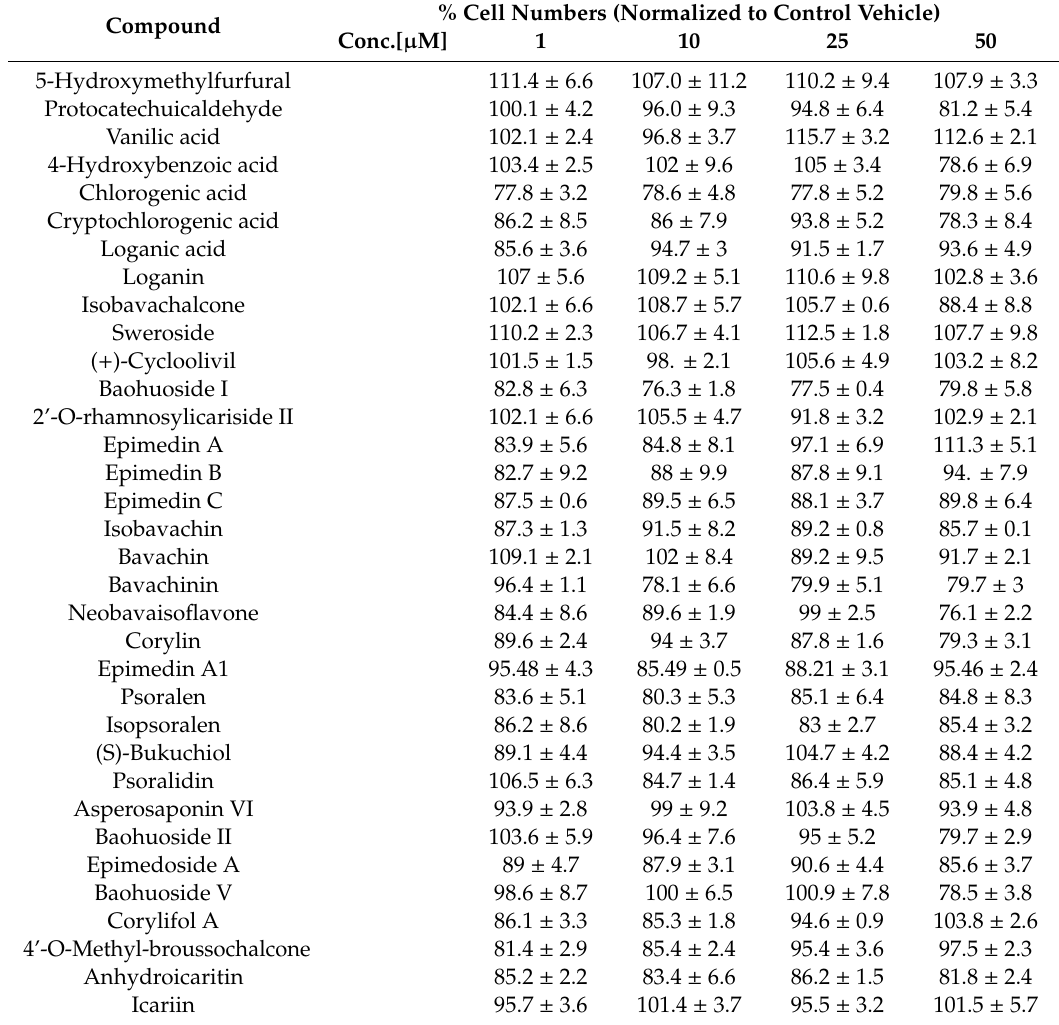
Table 1. Relative viable cell count after treatment with the 34 compounds measured by WST-1 assay. % Cell Numbers (Normalized to Control Compound